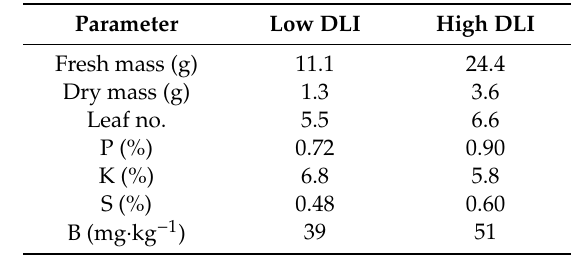
Table 6. Fresh and dry mass, leaf number, and P, K, S and B concentrations of parsley ( Petroselinum crispum ‘Giant of Italy’) 4 weeks after transplanting into nutrient-film technique hydroponic systems in a greenhouse under a low (~7 mol · m − 2 · d − 1 ) or high (~18 mol · m − 2 · d − 1 ) daily light integral (DLI) with a range of nutrient solution electrical conductivity (EC; 0.5 to 4.0 dS · m − 1 ) treatments. Data were pooled across EC treatments within DLI for each species. Each value represents the mean of three